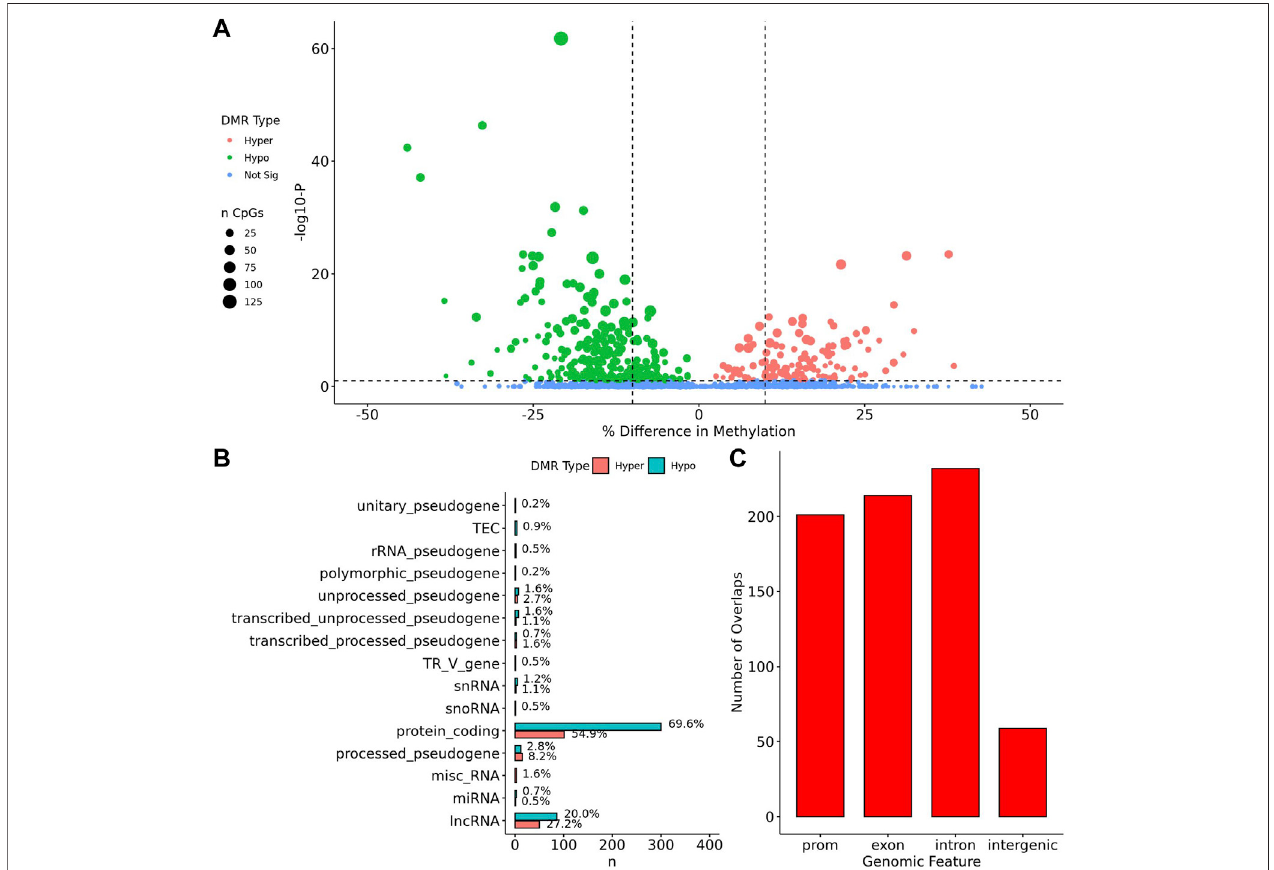
FIGURE 4 | Feature enrichment for genes overlapping TS BAV DMRs. (A) Barplot of DMR overlap with CpG islands, ENCODE cCRE, and GeneHancer elements. (B) DotplotofLOLAfeatureoverlapwithenrichmentforcCREs,CTCFChIP-seqpeaks,LaminB1nuclearlaminainteractions,andCoriellCellLineCopyNumberVariants (coriellDelDup table). (C) Three signi fi cant TS BAV DMRs displayed in the UCSC Genome Browser with ENCODE cCREs and H3K27Ac tracks over the DUSP22 gene locus.